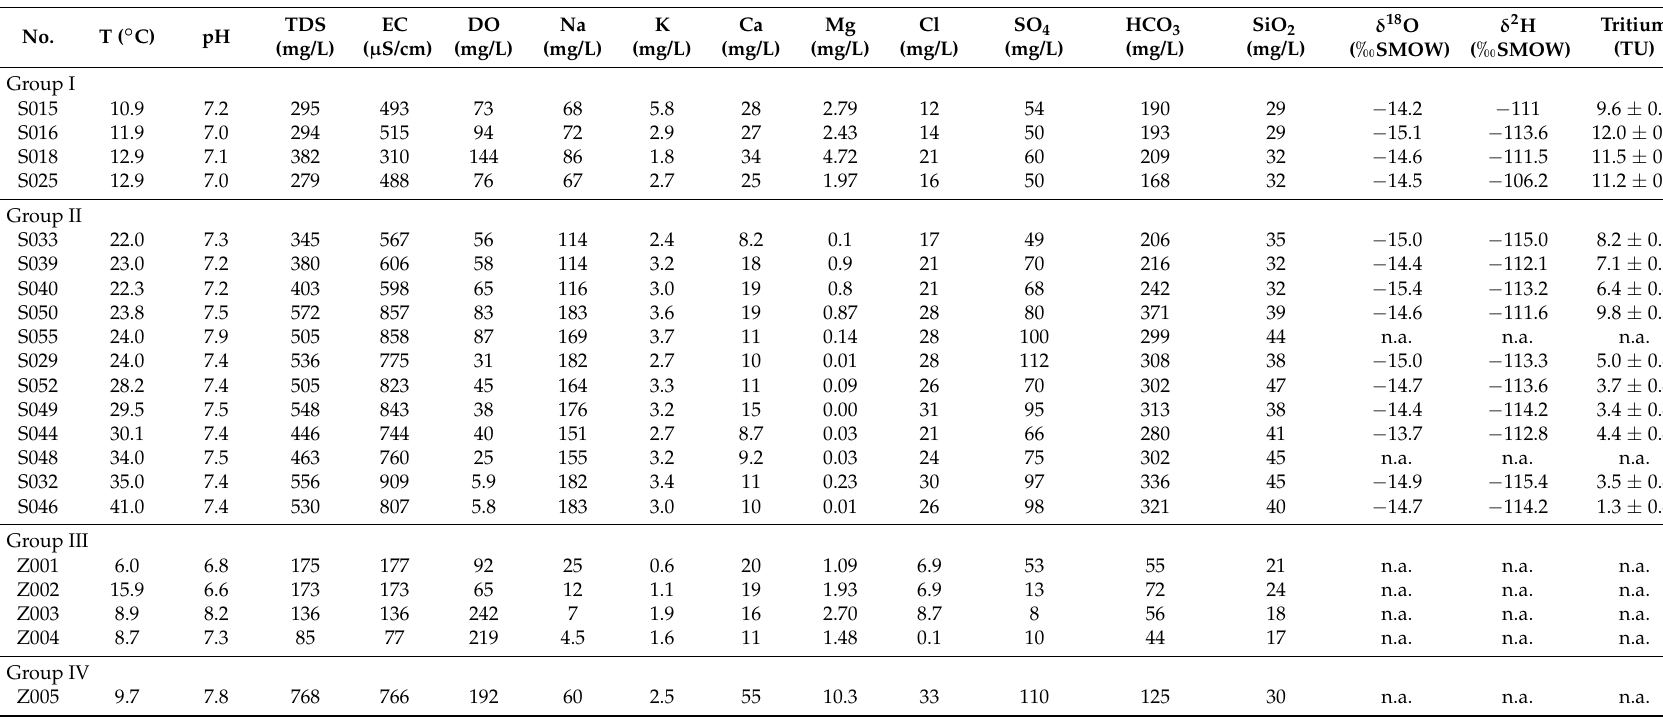
Table 1. Results of the chemical analysis of the samples. n.a., not analyzed; T, water temperature; TDS, total dissolved solids; EC, electrical conductivities; DO, dissolved